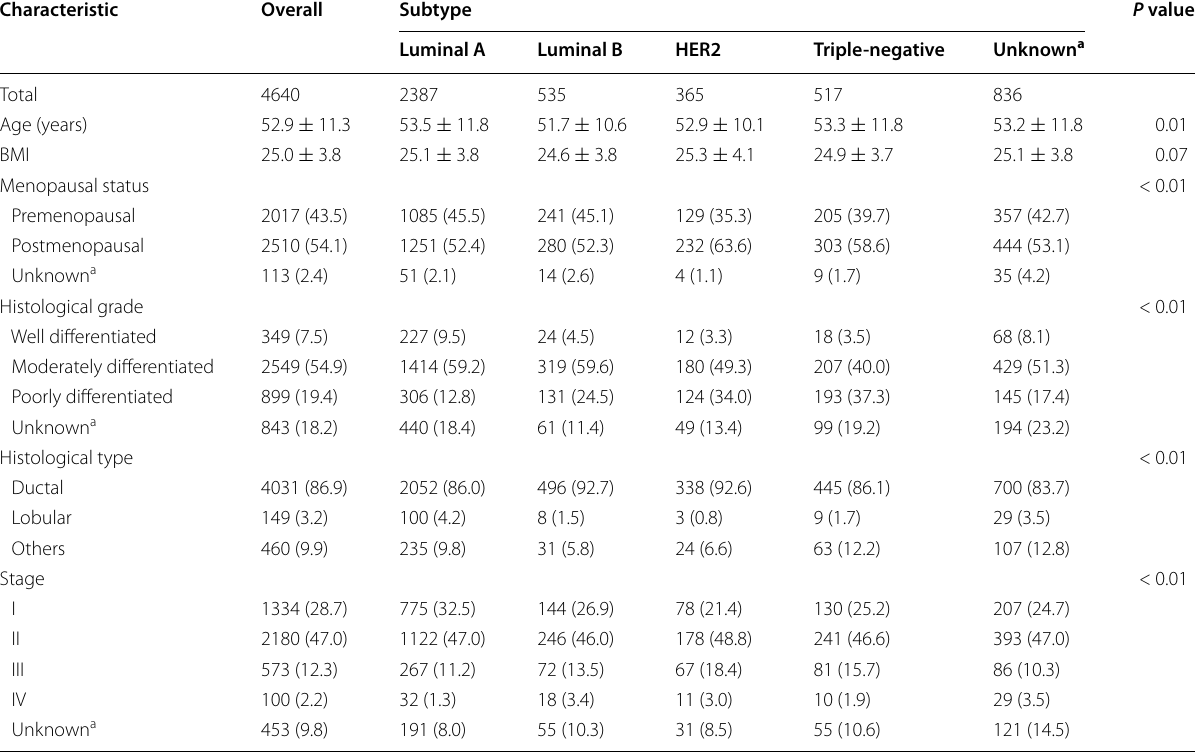
Table 2 Characteristics of breast cancer patients by molecular